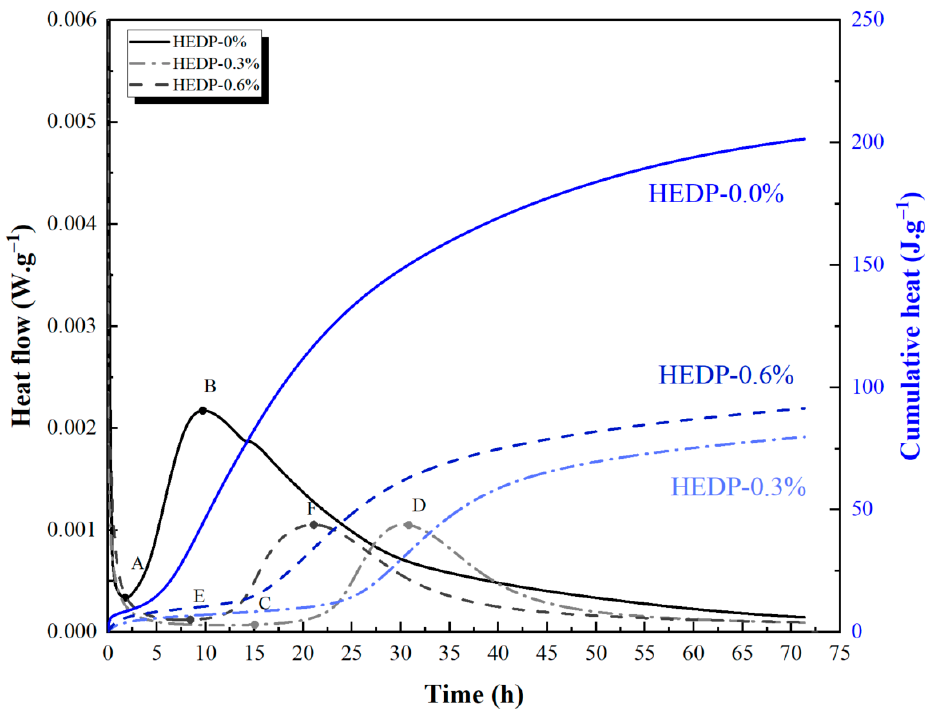
Figure 8. Heat of hydration for